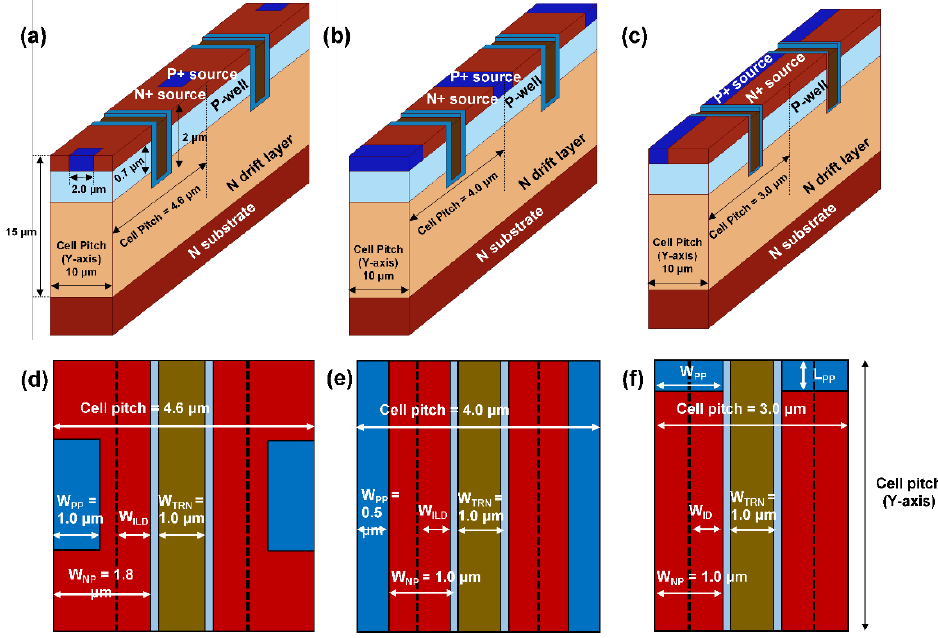
Figure 1. ( a ) Conventional trench-gate MOSFETs with P+ source with square pattern, ( b ) stripe pat- tern, and ( c ) grid pattern. Top view of TMOSFETs with P+ source with ( d ) square pattern, ( e ) stripe pattern, and ( f ) grid pattern.